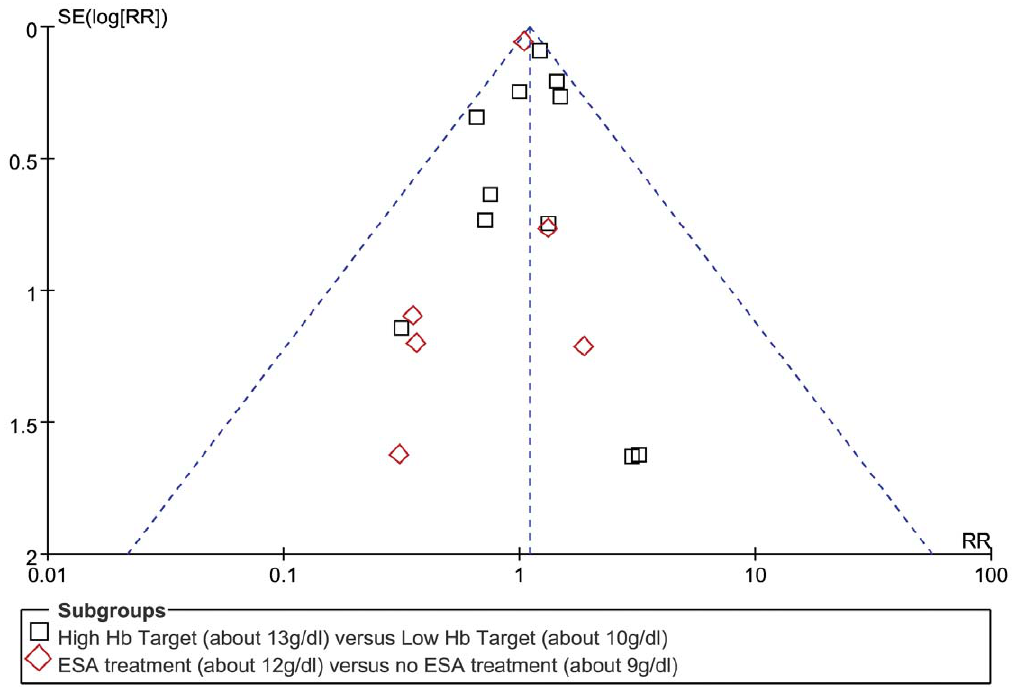
Figure 4. Funnel plot with 95% CI to evaluate publication bias in the two subgroups. One study with no events in both groups was